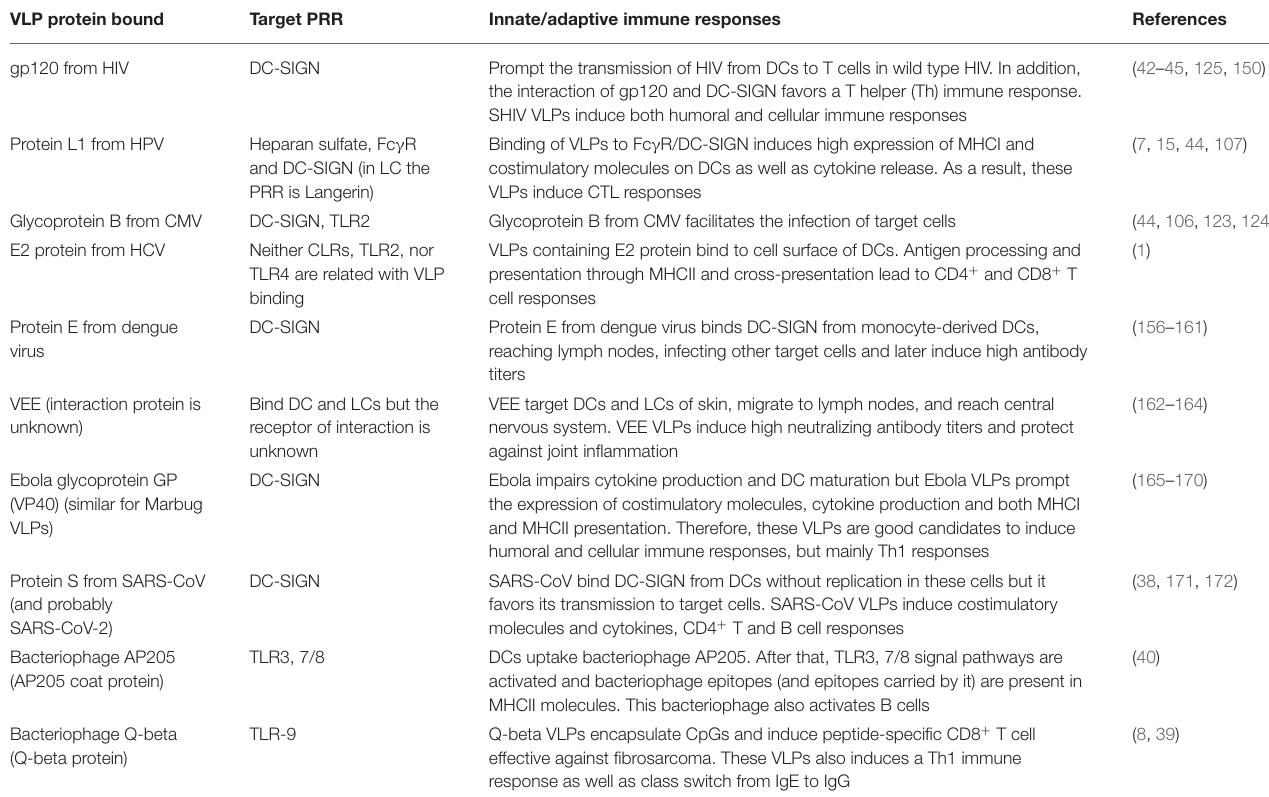
TABLE 1 | DC PRRs that interact with proteins forming VLPs and prompt an immune